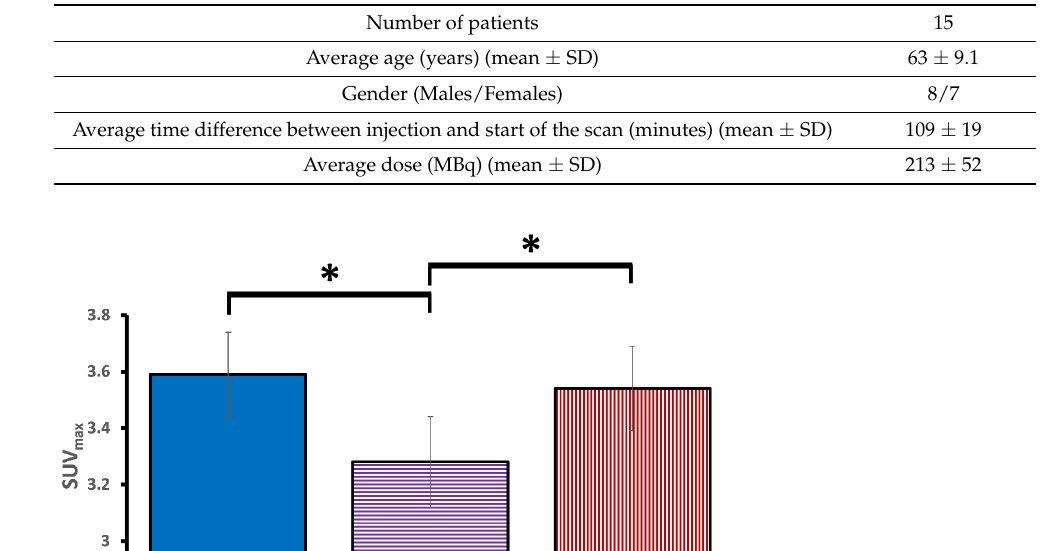
Table 3. Characteristics of the patients included in the study.